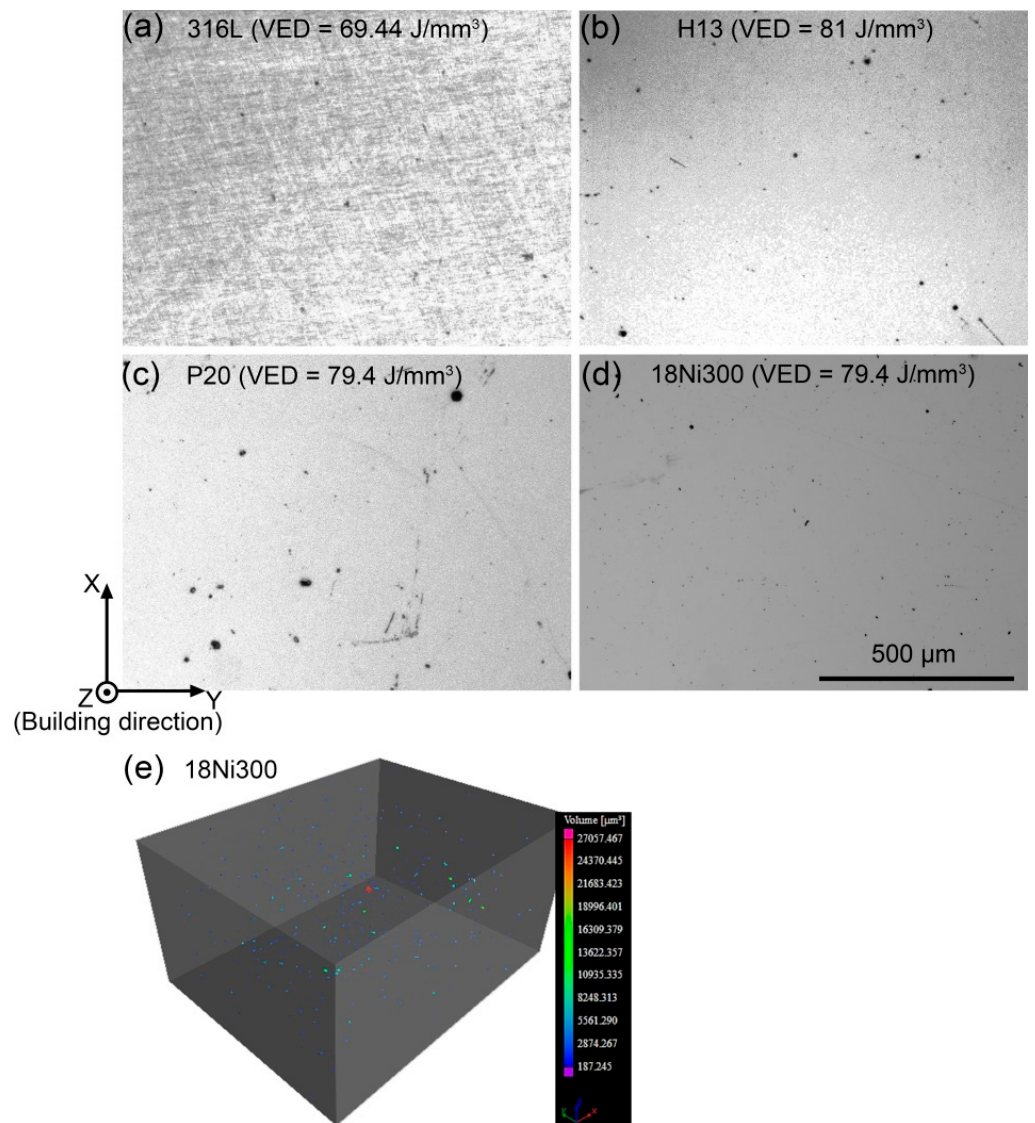
Figure 9. Optical microscope images of ( a ) 316L, ( b ) H13, ( c ) P20 and ( d ) 18Ni300 parts produced by selective laser melting (SLM) and CT image for ( e ) 18Ni300. Table 3. Selective laser melting processing parameters for the four steel powders.